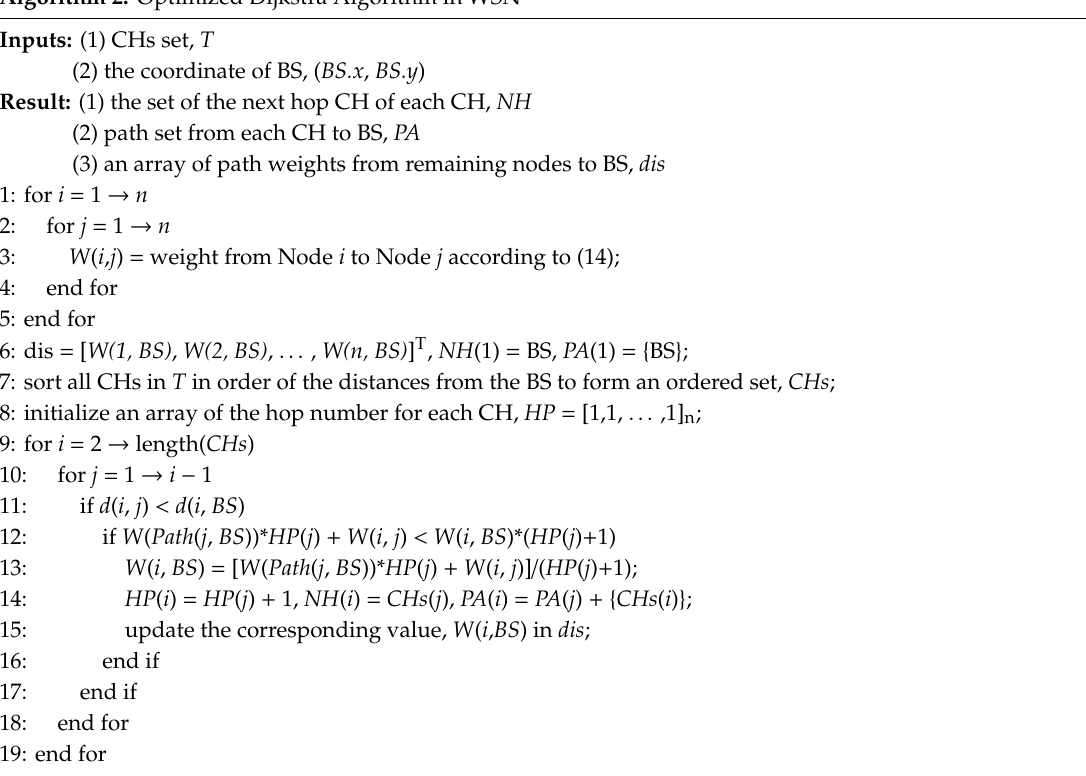
Algorithm 2. Optimized Dijkstra Algorithm in